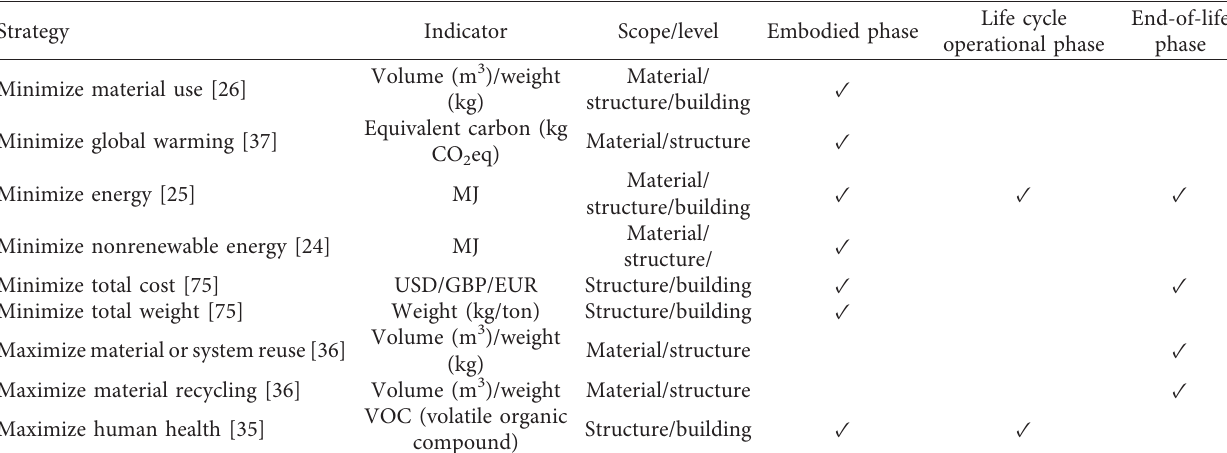
Table 4: Summary of SSD strategies and